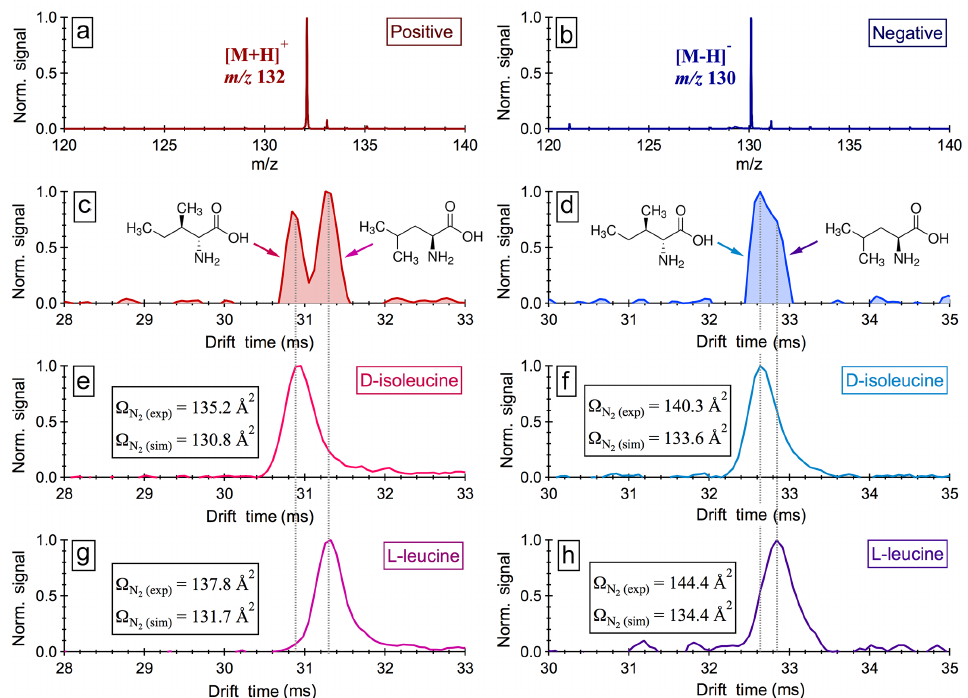
Figure 6. (a, b) ESI mass spectra collected for an equi-molar mixture (20µM each) of L-leucine and D-isoleucine in positive and negative mode. (c, d) Measured drift time distributions for the leucine mixture in positive and negative mode. (e, f) Measured vs. predicted (cid:127) N isoleucine, together with its drift time distributions in positive and negative mode. (g, h) Measured vs. predicted (cid:127) N with its drift time distributions in positive and negative mode. Note that all measurements were performed at ∼ 303K and ∼ 1019mbar with an electric field strength of 414 and 403Vcm − 1 in the positive and negative mode,